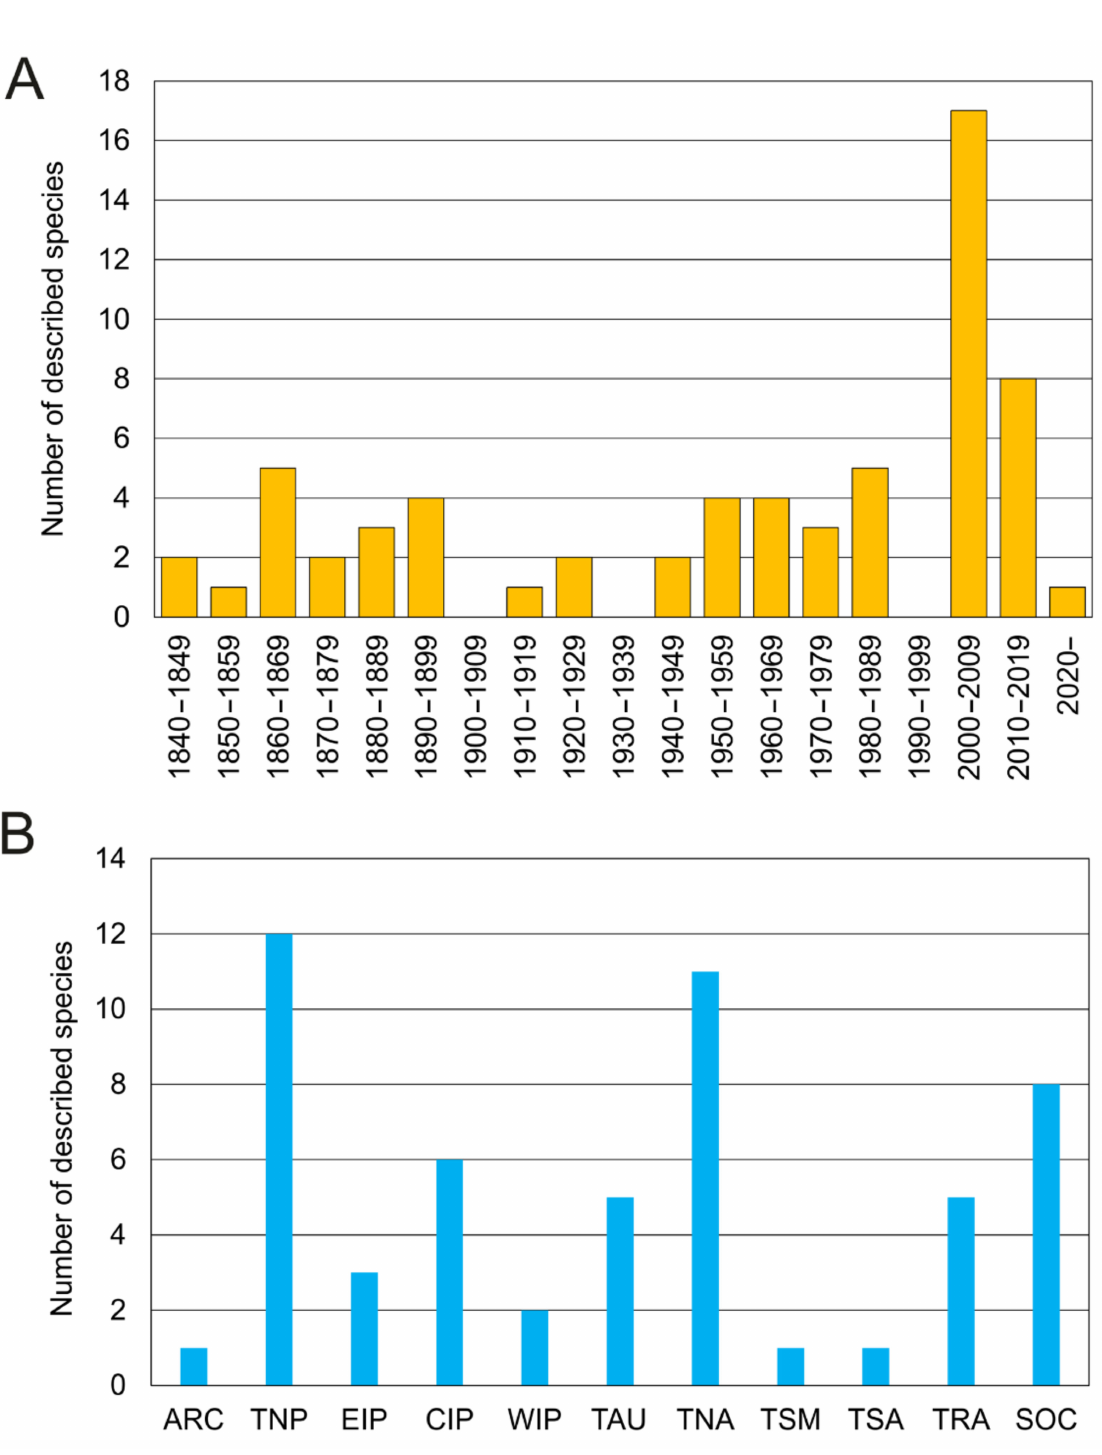
Figure 12. ( A ) Number of oweniid species described per decade; ( B ) all oweniid species currently consider valid [85] listed under the bioregion (sensu [86]) of their type locality. Abbreviations: ARC—Arctic; TNP—temperate North Pacific; EIP—Eastern Indo-Pacific; CIP—Central Indo-Pacific; WIP—Western Indo-Pacific; TAU—temperate Australasia; TNA— temperate Northern Atlantic; TSM—temperate South America; TSA—temperate South Africa; TRA—tropical Atlantic; SOC—Southern